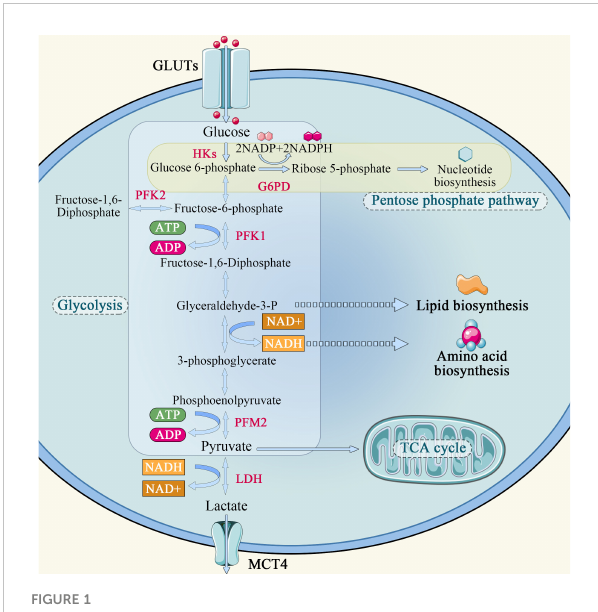
FIGURE 1 Schematic diagram of glucose metabolism in tumor